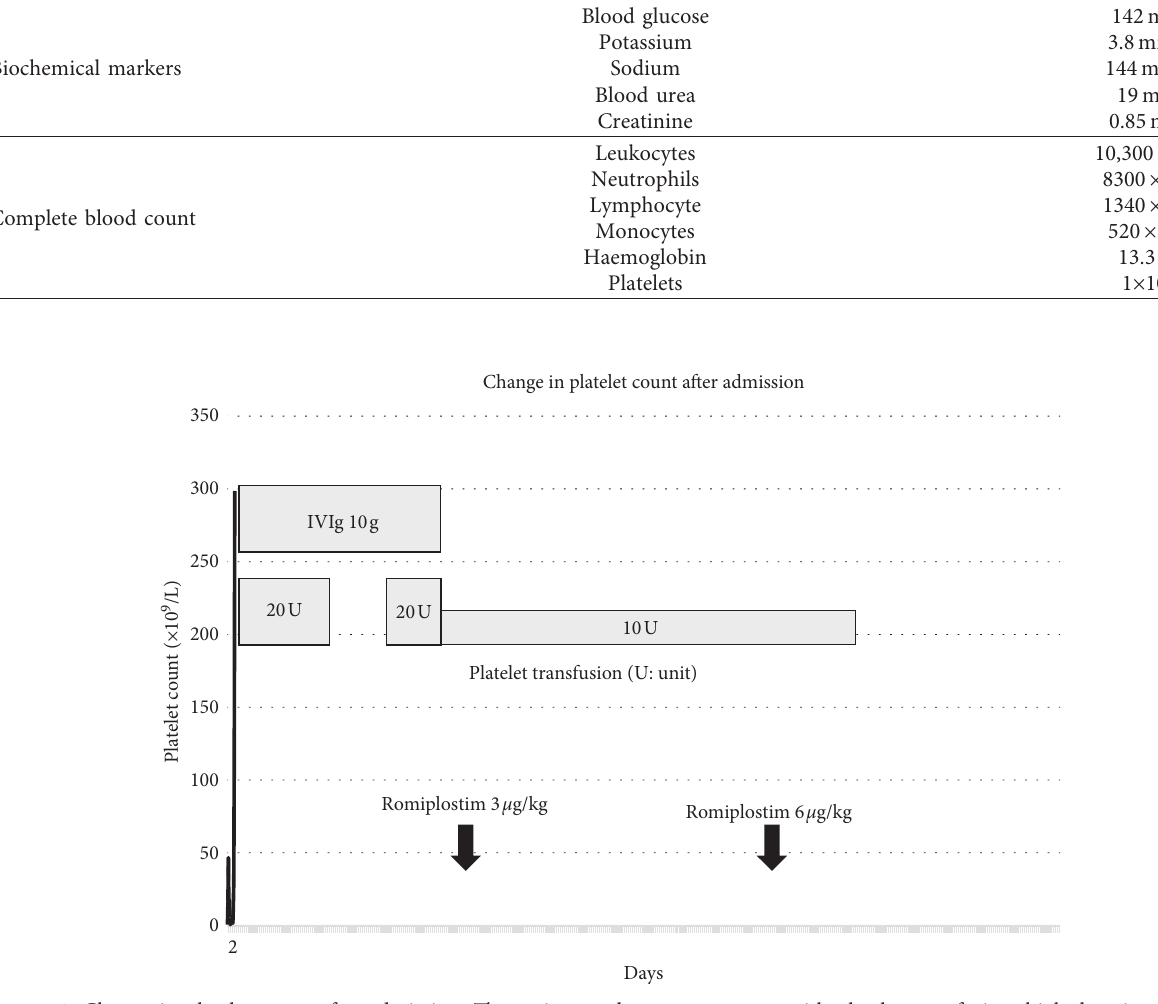
Figure 1: Change in platelet count after admission. The patient underwent treatment with platelet transfusion, high-dose intravenous gamma-globulin (IVIG), and romiplostim. Platelet counts increased about 14 days after